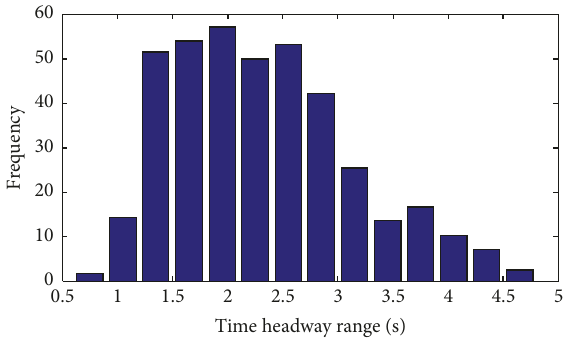
Figure 3: Observed vehicle gap